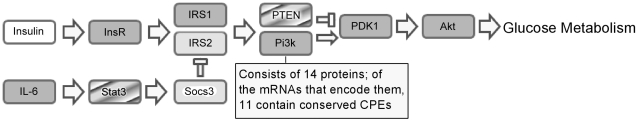
Proposed model for CPEB-dependent regulation of the insulin-signaling ribonome regulation.The dark gray boxes refer to mRNAs that contain conserved CPEs and can potentially be regulated by CPEB. The light gray boxes refer to mRNAs that contain conserved CPEs but because they are not co-immunoprecipitated with CPEB, are probably not regulated by this protein in the current settings. The striped boxes refer to mRNAs that contain conserved CPEs and are regulated by CPEB. Insulin mRNA does not contain a CPE.